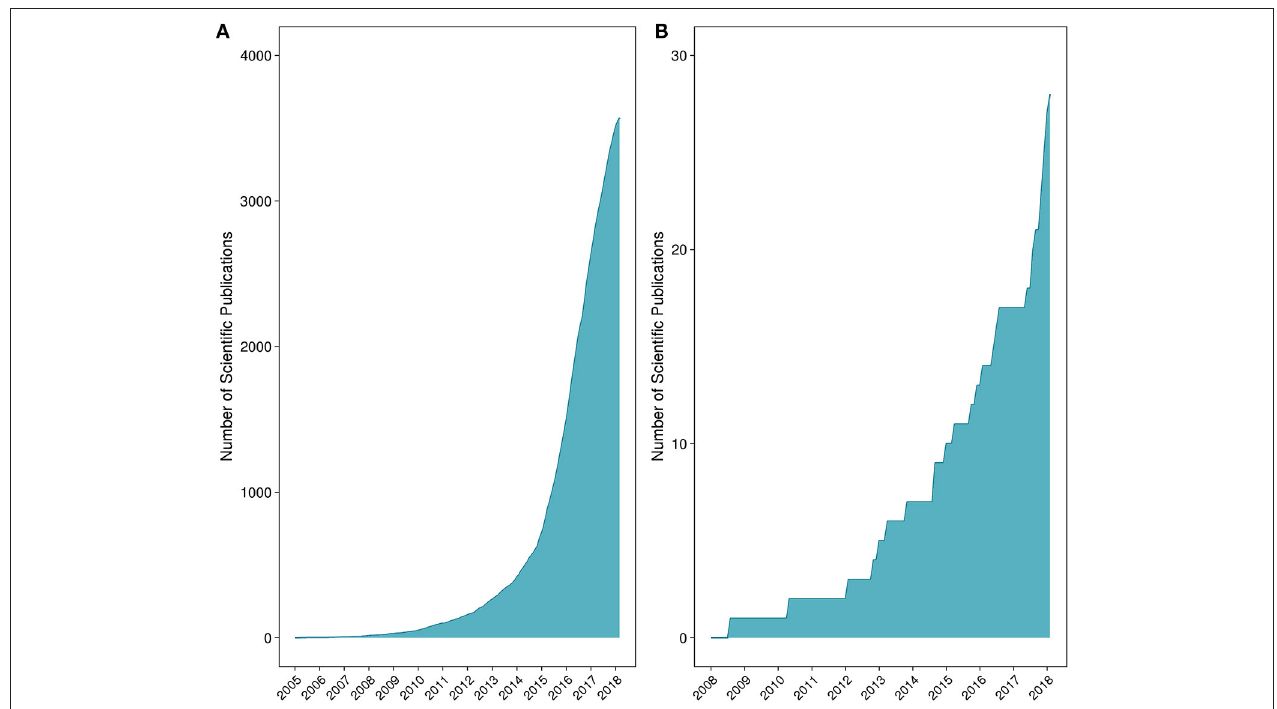
FIGURE 1 | Number of peer-reviewed scientific publications for (A) microbiome and (B) mycobiome studies. The list of peer-reviewed literature was collated through iterative searches of the National Center for Biotechnology Information’s PubMed database.